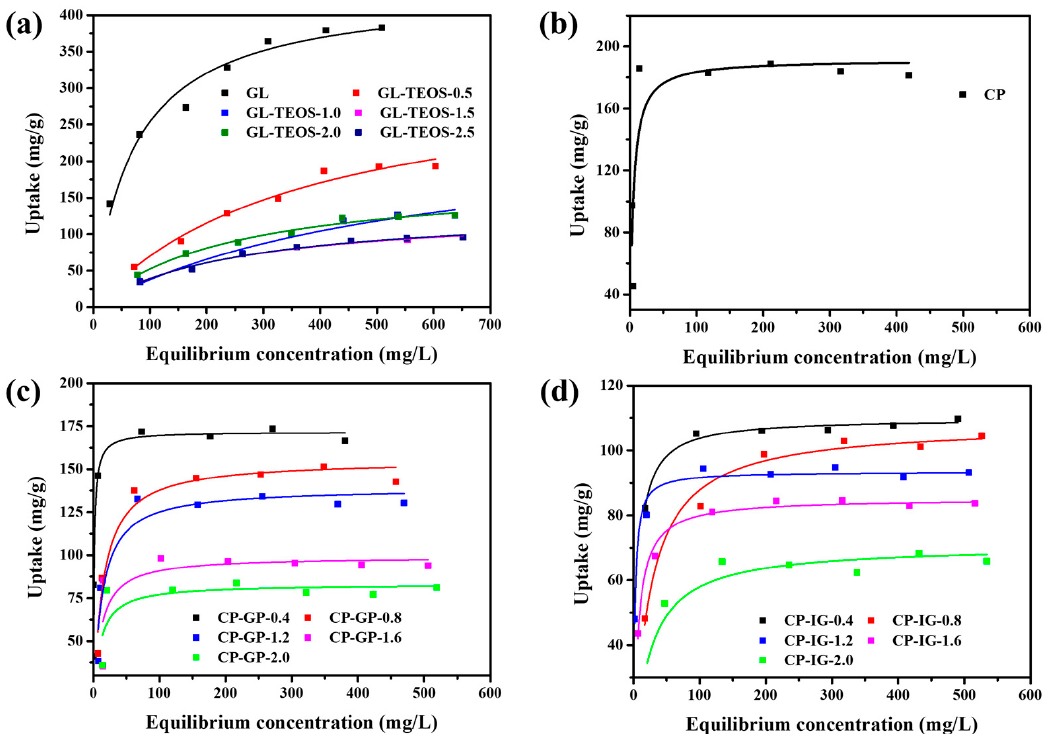
Figure 10. Equilibrium adsorption isotherms of MB on ( a ) GL and GL-TEOS-x (x =0.5, 1, 1.5, 2, and 2.5); ( b ) CP; ( c ) CP-GP-x (x = 0.4, 0.8, 1.2, 1.6, and 2.0); and ( d ) CP-IG-x (x = 0.4, 0.8, 1.2, 1.6, and 2.0). Table 3. The maximum adsorption capacity of the sample of GL and GL-TEOS-x (x = 0.5, 1, 1.5, 2, and 2.5); CP; CP-GP-x (x = 0.4, 0.8, 1.2, 1.6, and 2.0); and IP-CP-x (x = 0.4, 0.8, 1.2, 1.6, and 2.0) to MB.